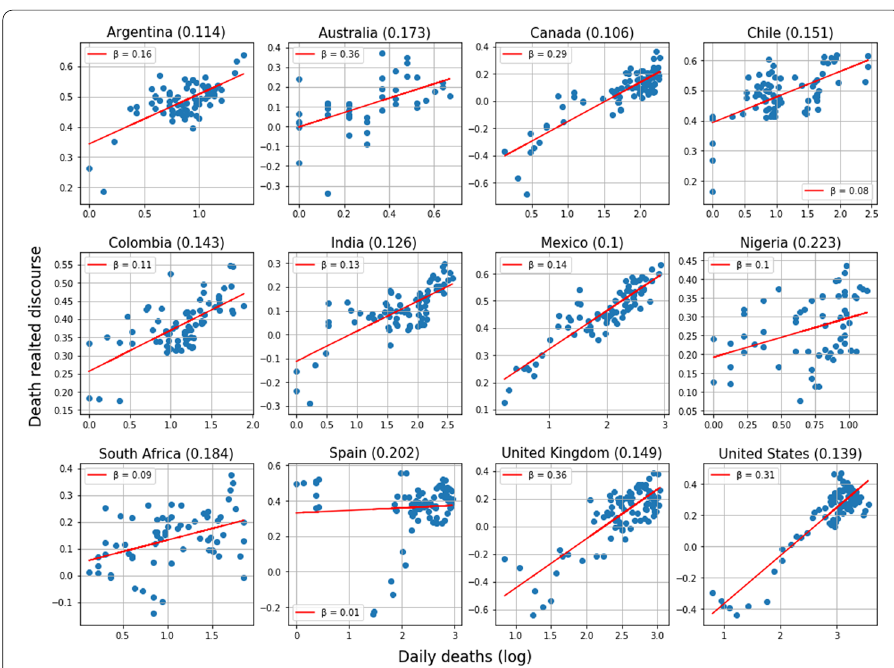
Fig. 9 Scatter plot for the power law model fit [see Eq. (11)], where each panel shows a different country with their corresponding NRMSE [see Eq. (12)] in parenthesis (the lower the